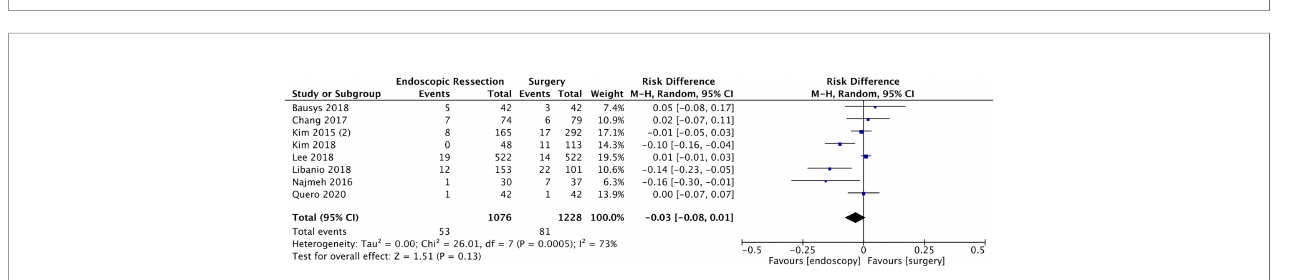
FIGURE 5 | Forest Plot Serious Adverse